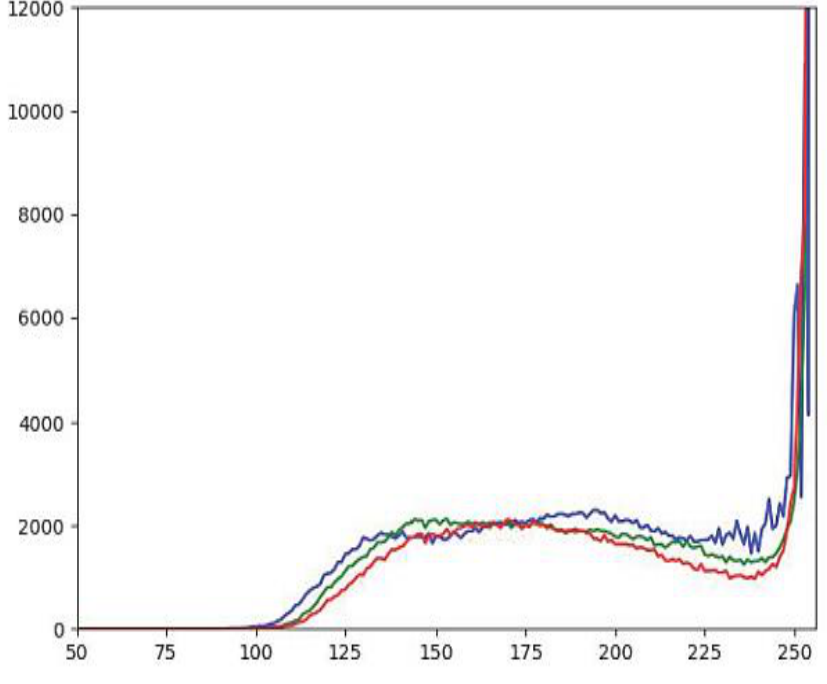
Figure 35. Histogram of the RGB graph for the image (see Figure